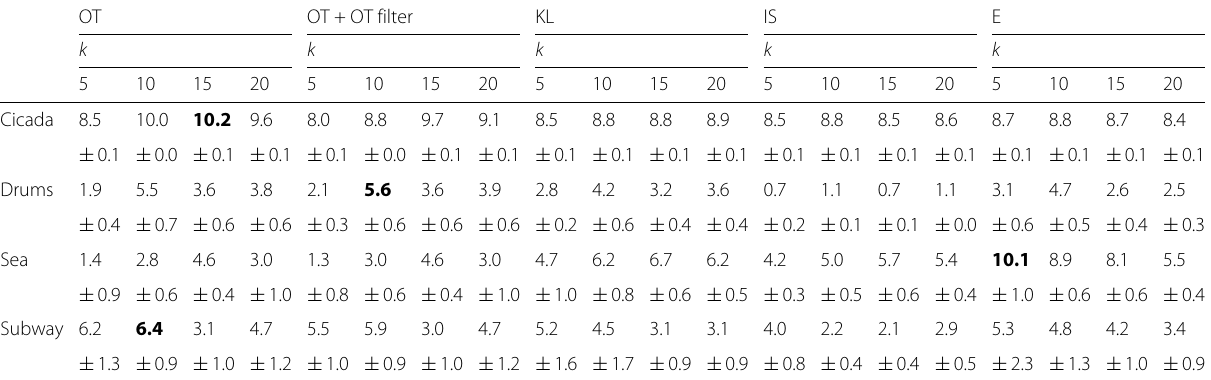
learned for the universal voice model and the cicada noise, respectively, with all losses and a dictionary size of 5 and Table 2 Speech denoising SIR scores